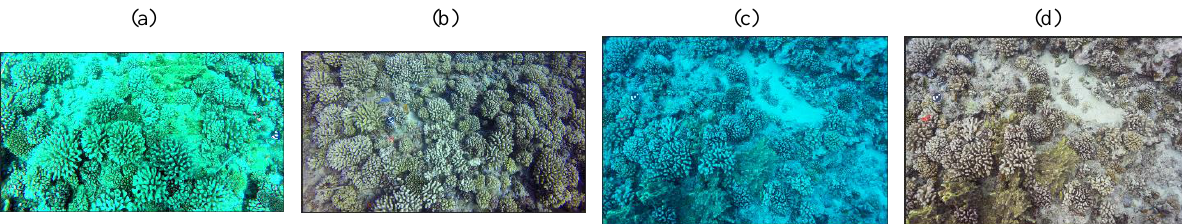
Figure 4. Frames extracted from a GoPro video recorded without (a) and with (b) the red filter. RAW images before (c) and after (d) WB